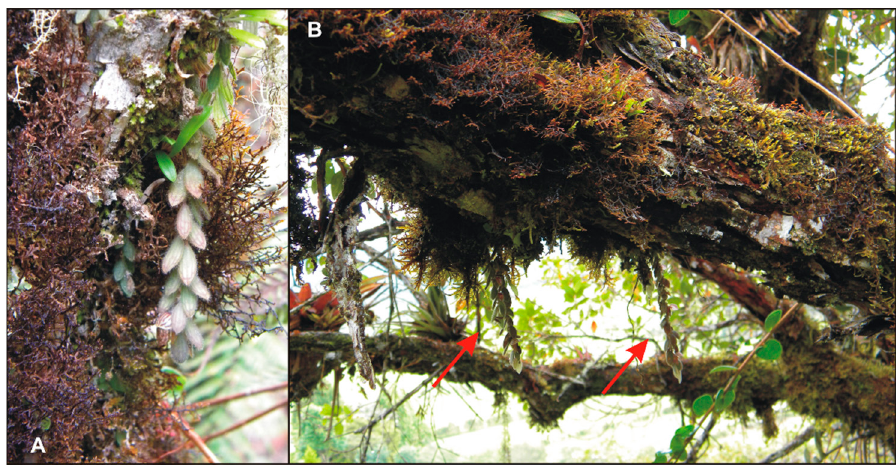
Figure 14. Neooreophilus medinae Kolan. & Szlach.—plant in situ. ( A )—plant habit, ( B )—plants hanging on a branch covered by mosses in natural